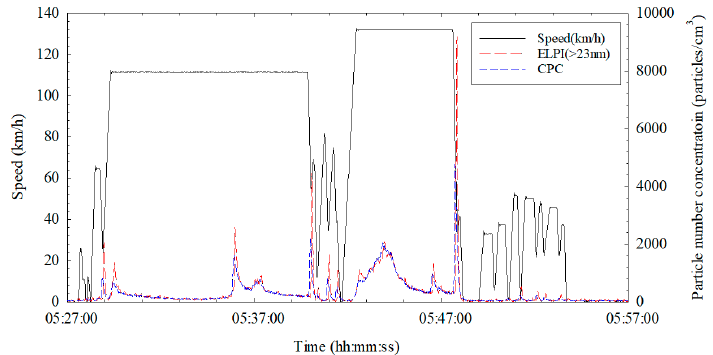
Figure 6. Particle number concentration variations measured by the CPC and the ELPI during the WLTP-brake.